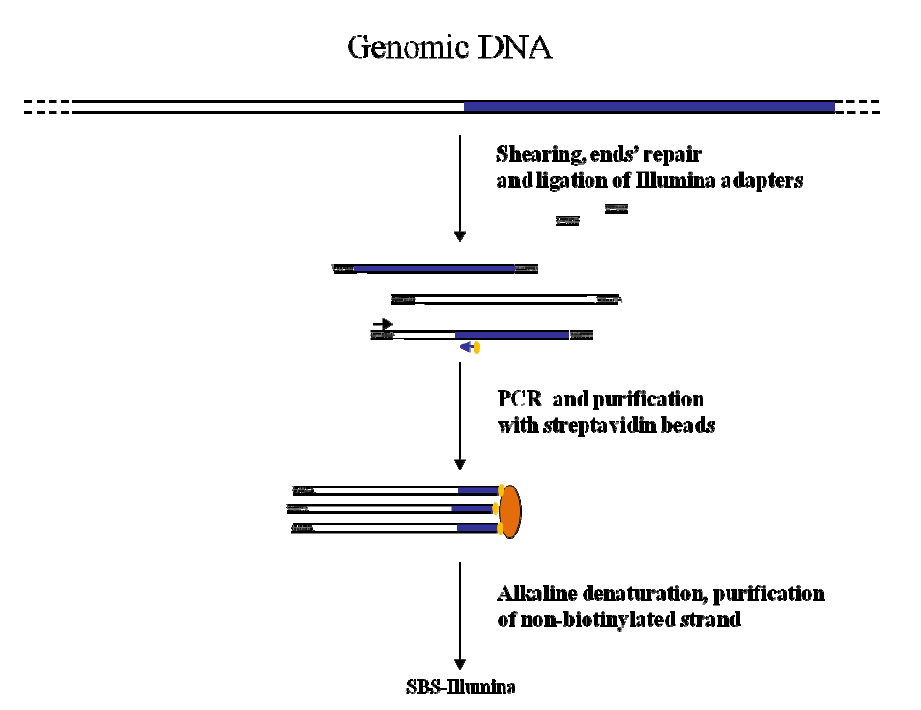
Figure 3. Main steps of cassette-PCR GW and sequencing by synthesis (SBS)-Illumina association strategy. Blue and white bars correspond to known and unknown sequences, respectively. A blue arrow with a small yellow oval corresponds to biotinylated primers in the known nucleotide region. A black horizontal arrow indicates adapter specific primers. An orange oval indicates a streptavidin magnetic